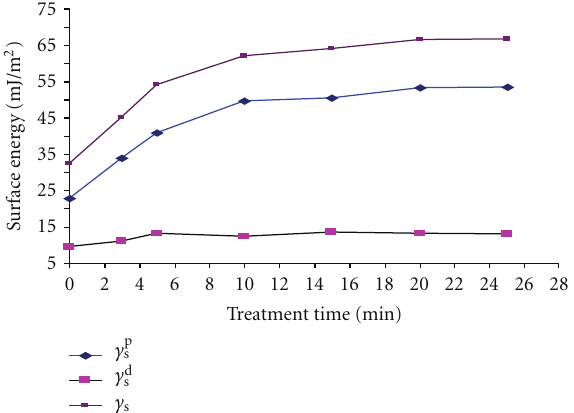
Figure 3: Surface energy of PC film with respect to treatment time.